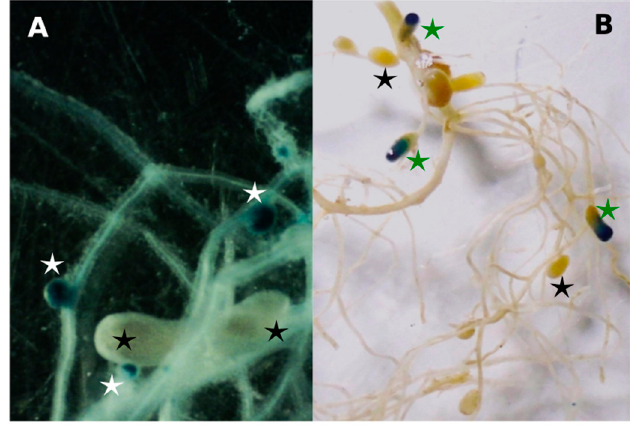
Figure 1. Nodule morphology. ( A ) Staining of nodulated roots of T. repens plants collected 21 days after seed co-inoculation. Magnification: 10X. ( B ) Staining of nodulated roots of T. repens plants col- lected at 35 dpi with U204 and UP3:: gusA . Magnification: 3X. Nodules infected with UP3:: gusA are indicated with white stars compared with non-stained nodules from U204 in black stars. Partially stained nodules are indicated with green stars.